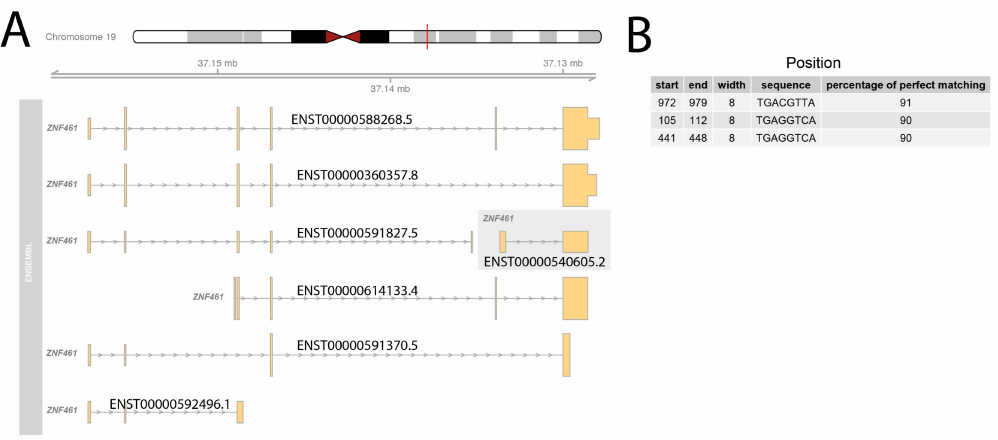
Figure 10. Analysis of the human ZNF461 (zinc finger protein 461) gene promoter sequence for the presence of conservative CREB1 (cAMP responsive element binding protein 1) binding sequence. ( A ) Structure of human ZNF461 splice variants. The exons are highlighted in orange. The exons